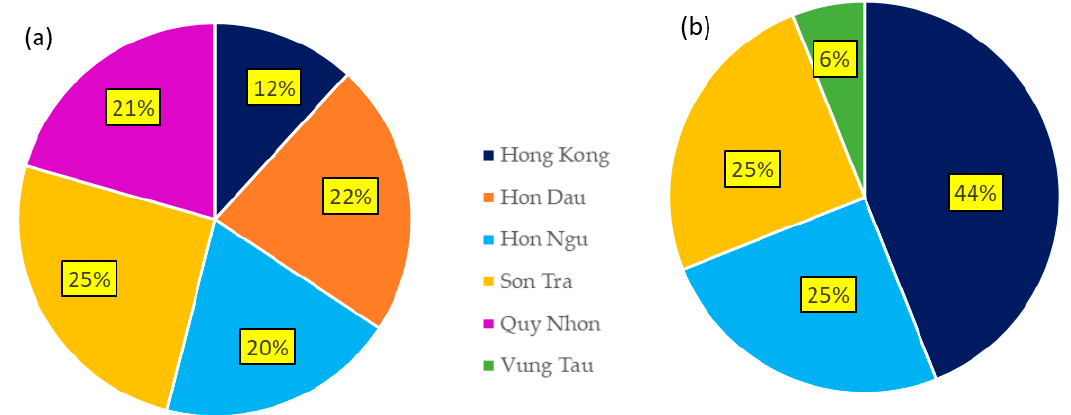
Figure 15. Percentage of frequency of forerunner ( a ) and the combination of forerunner and onshore wind ( b ).